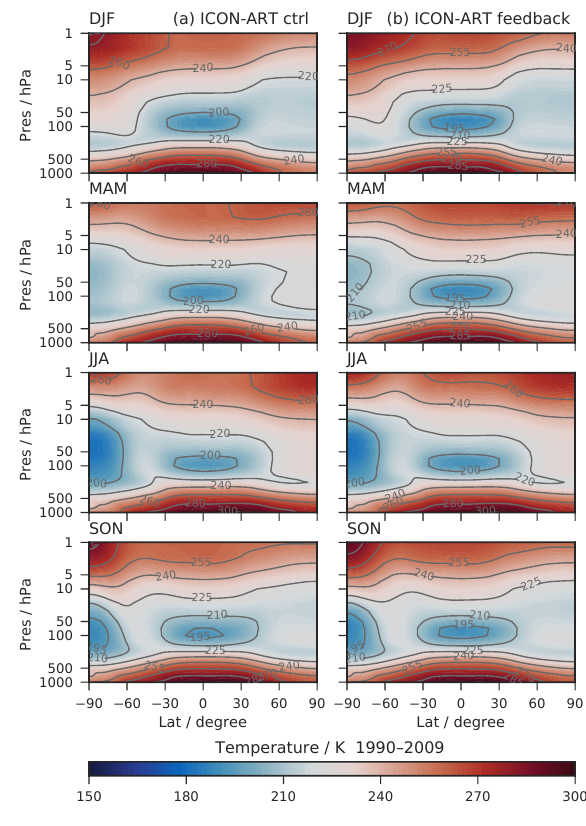
Figure 8. Latitude–height cross sections of seasonal and zonal mean temperature (K) for ICON-ART simulations from 1990 to 2009. (a) Control run; (b) feedback simulation.